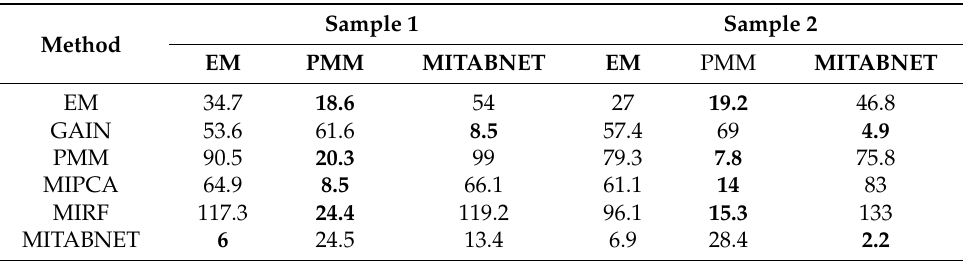
Table 2. Values of the percentage bias for three imputation methods using two imputed bootstraps from the NSCLC Flatiron